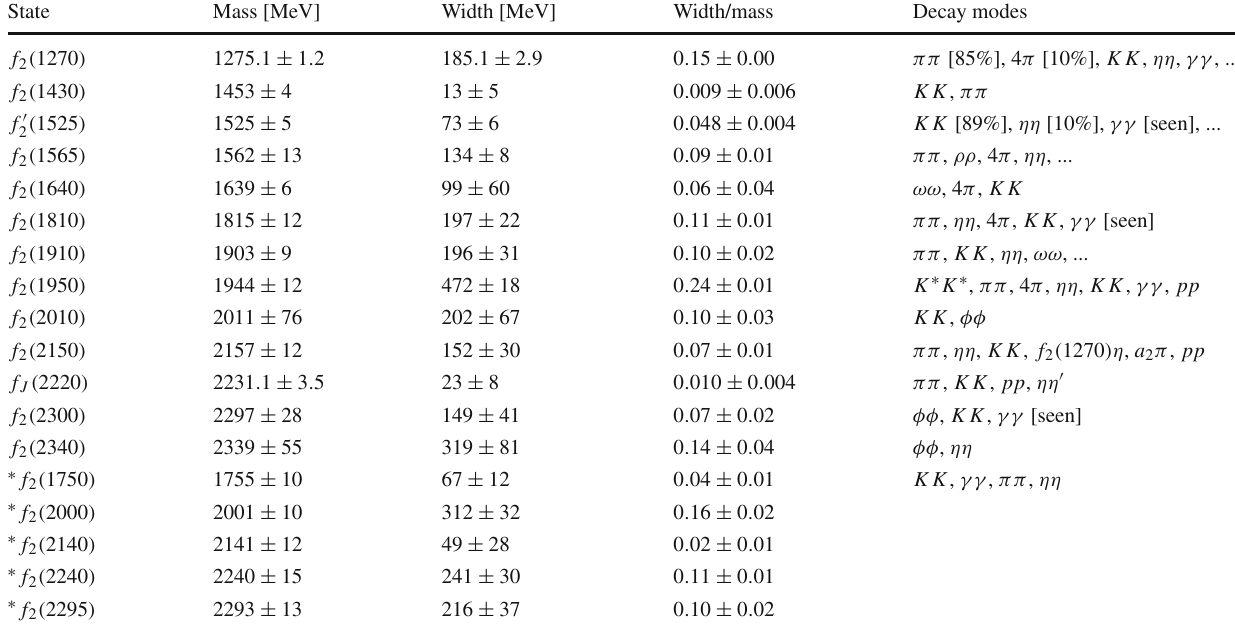
Table 17 All the f 2 states as listed by the PDG. The last few states, marked here by asterisk, are classified as “further states”